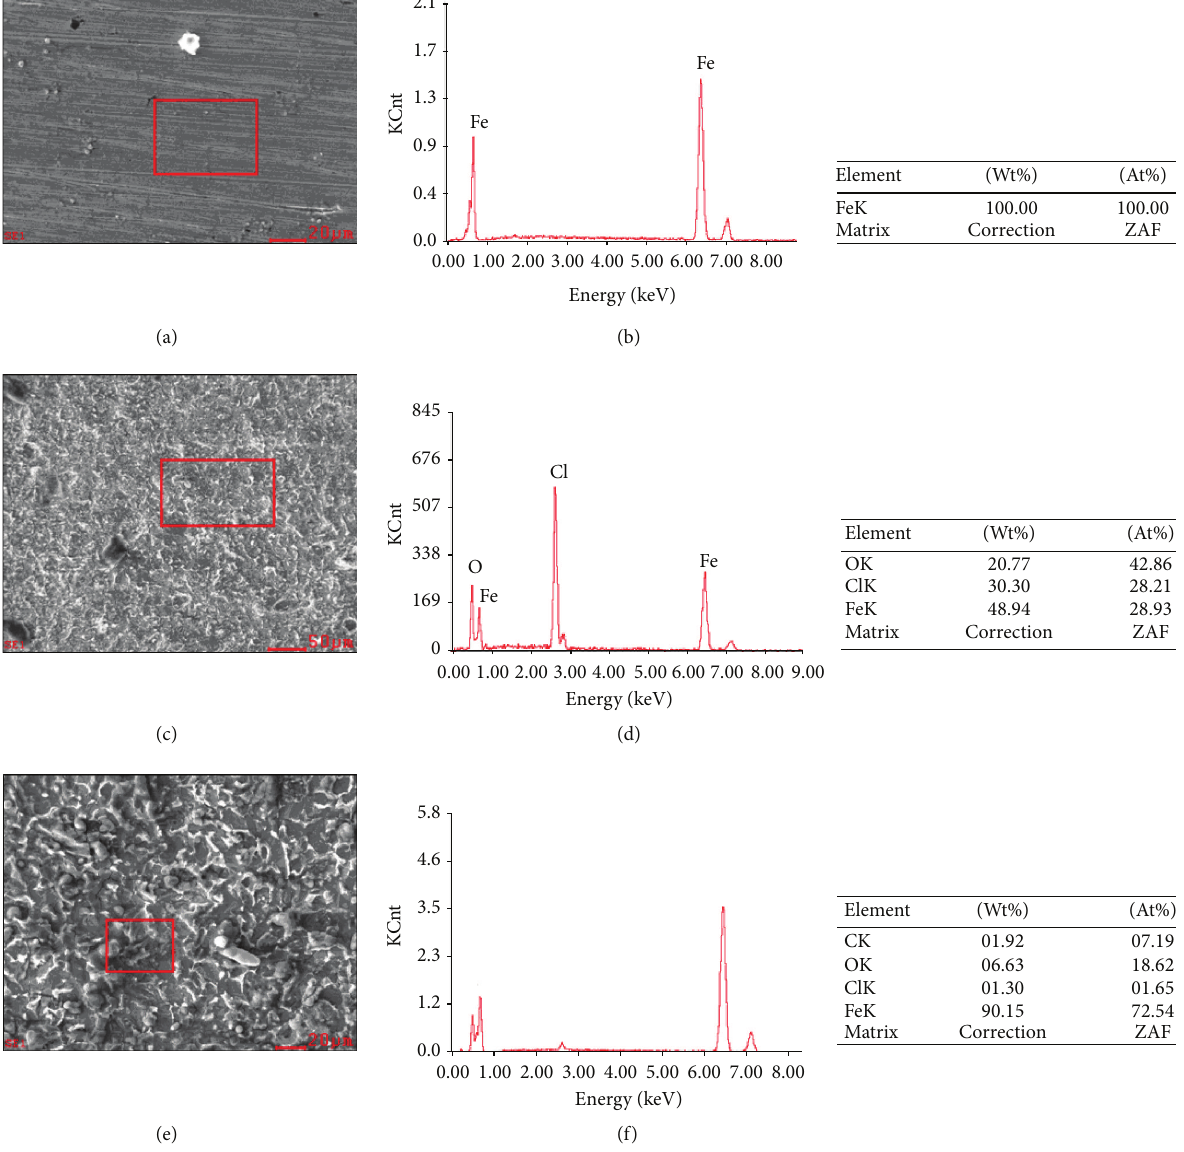
Figure 1: SEM image and EDS analysis of the N80 before exposure to 15% HCl medium (a) and (b) after exposure to the acidic medium (c) and (d), in 15% HCl medium with the addition of 0.004 M TU and 0.1 M HMTA (e) and (f) at 25 ± 1 ∘ C,